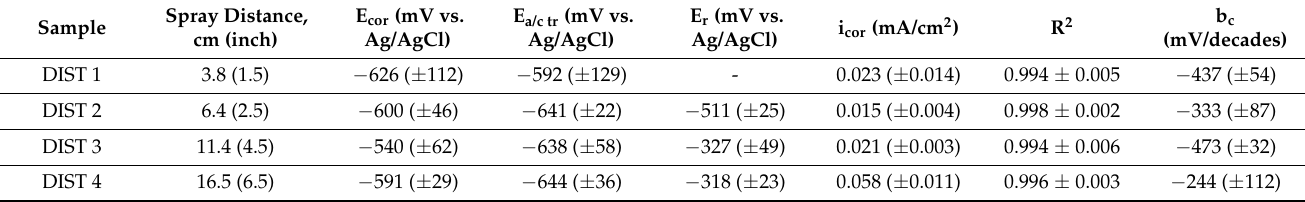
Table 4. Electrochemical values of the coatings immersed in 3.5% NaCl at 25 ◦ C: Effect of spray